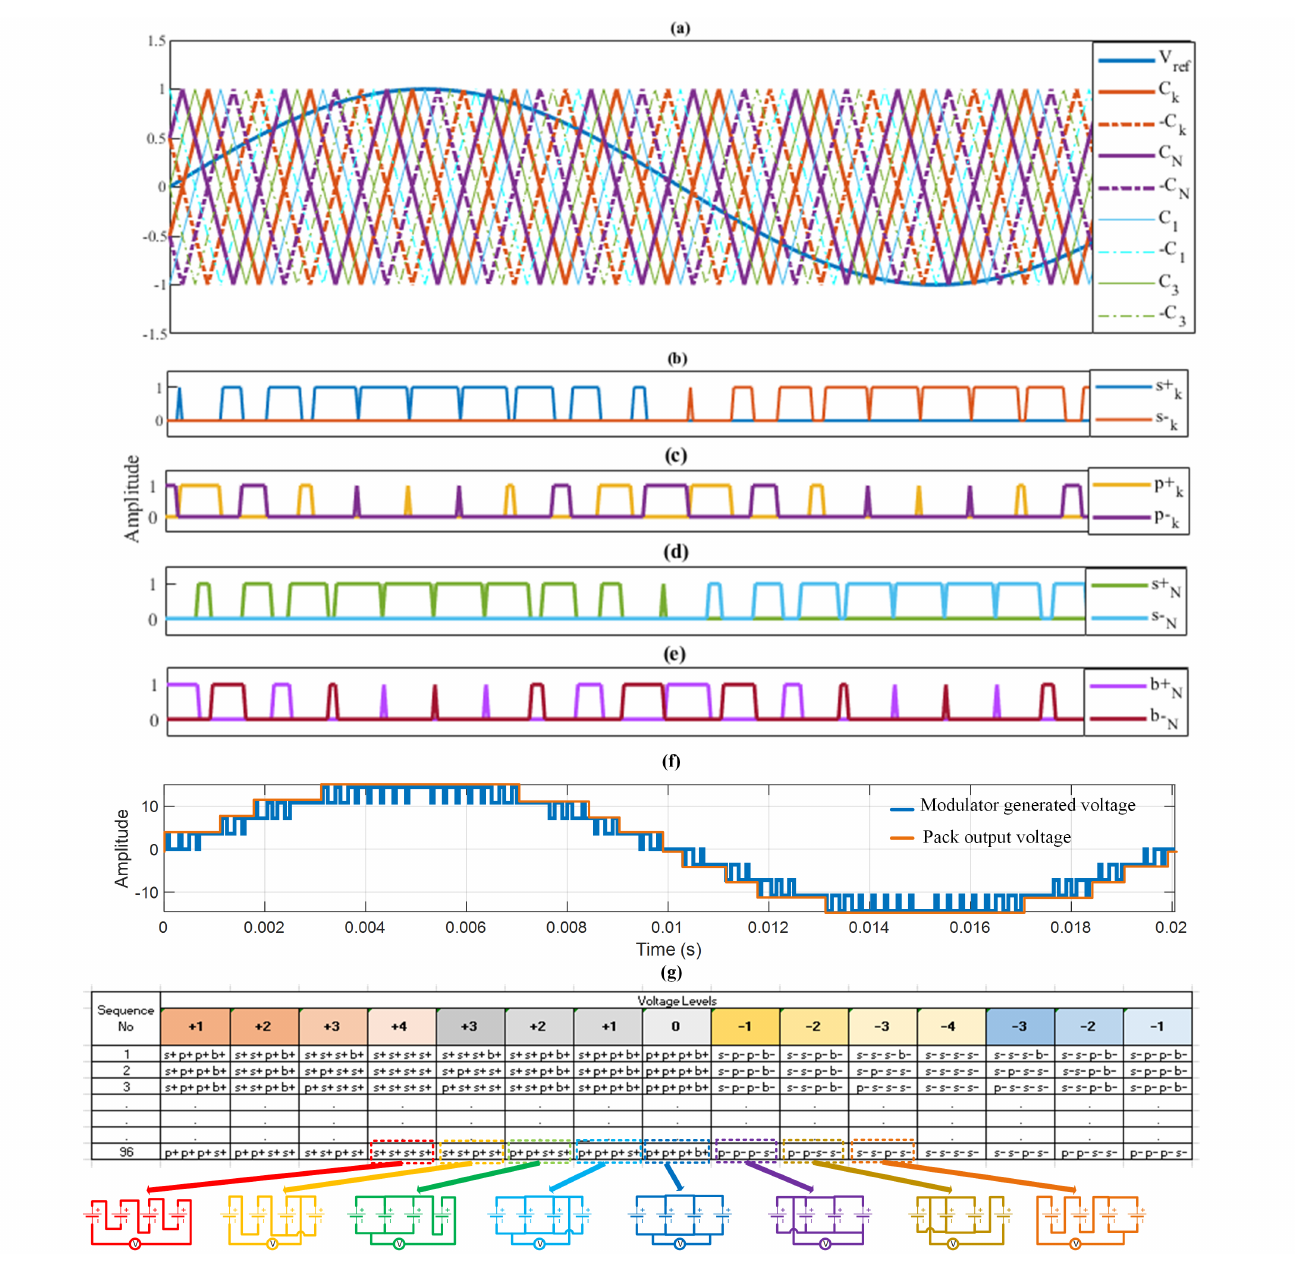
Figure 5. ( a ) PS-PWM sinusoidal reference waveform and carrier waveform, k th interconnection ( b ) series positive and negative interconnection command, ( c ) parallel positive and negative intercon- nection command, N th interconnection ( d ) series positive and negative interconnection command, ( e ) bypass positive and negative interconnection command, ( f ) nine level waveform generated by the modulator and the pack output voltage, ( g ) 96 sequences of possible cell configurations with respect to the voltage levels and cell configuration schematics for some selected switching arrangements for a battery pack with four